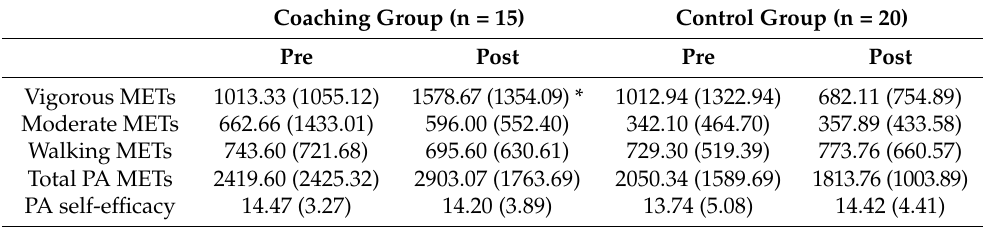
Table 3. Pre and post PA results between the PA goal group and the control group.